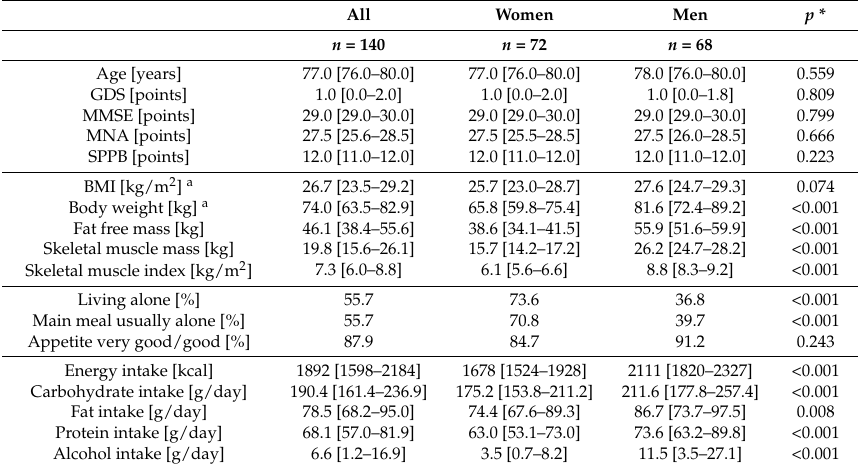
Table 1. Characteristics of healthy community-dwelling older adults (median